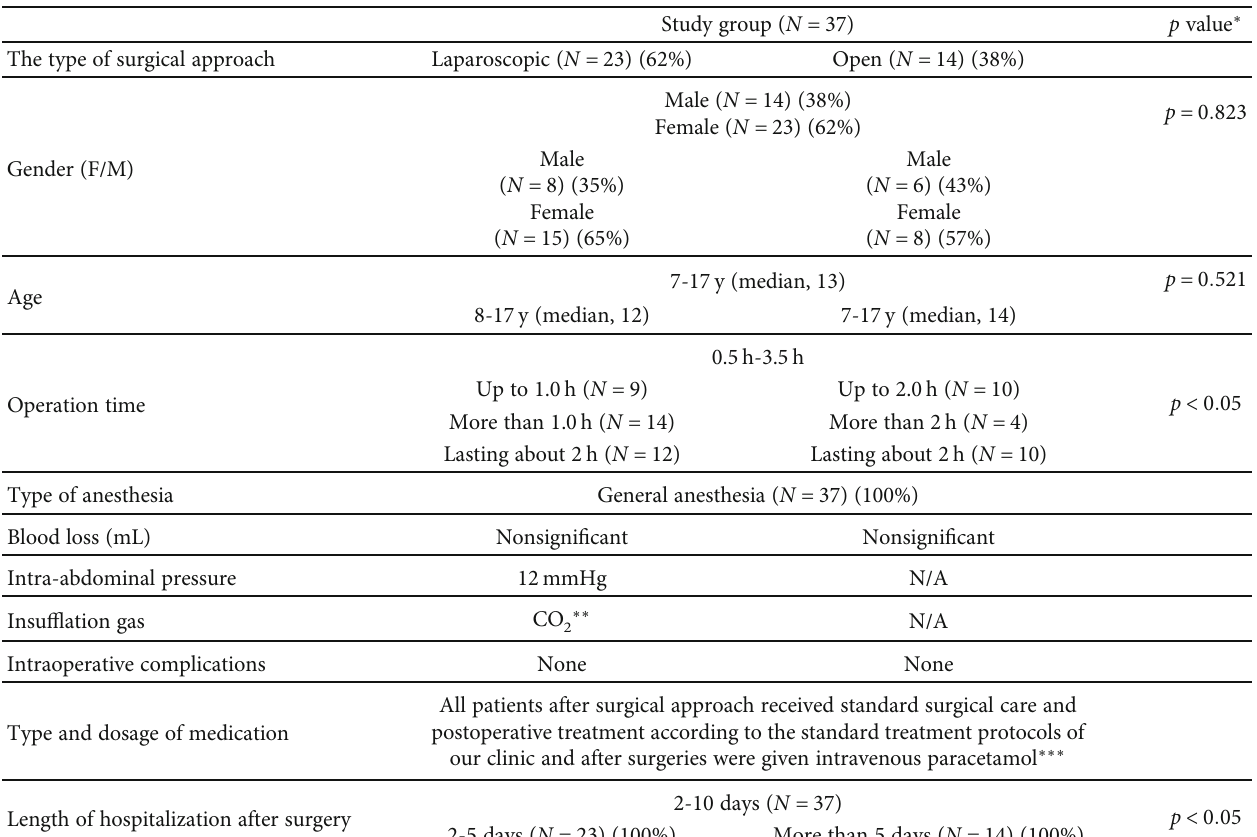
Table 1: Characteristics of the patients directed to cholecystectomy.